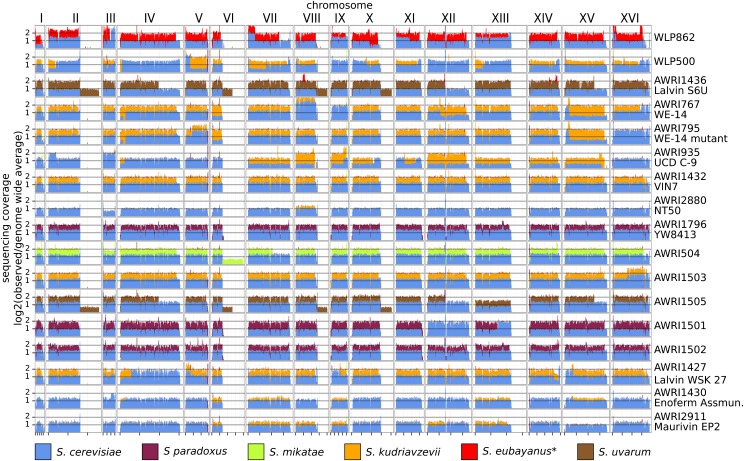
Inter-specific hybrids. Sequence coverage is displayed for strains that contained at least a 10% contribution from at least one chromosome from a non-S. cerevisiae. Coverage values are normalized to the genome wide average, with values color coded according to the donor species.